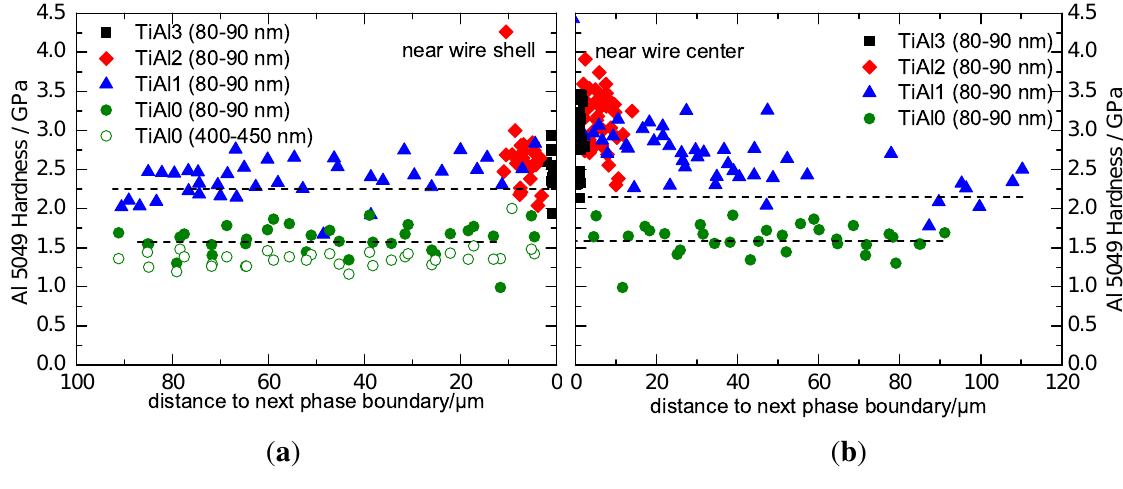
Figure 4. Nanoindentation hardness of the AA 5049 alloy taken ( a ) near the wire shell and ( b ) near the wire center of all composites. Note that data points for 2TiAl0 are the same in (a) and (b), since there is only one phase boundary. Numbers in brackets indicate the indentation depth from which the hardness value is